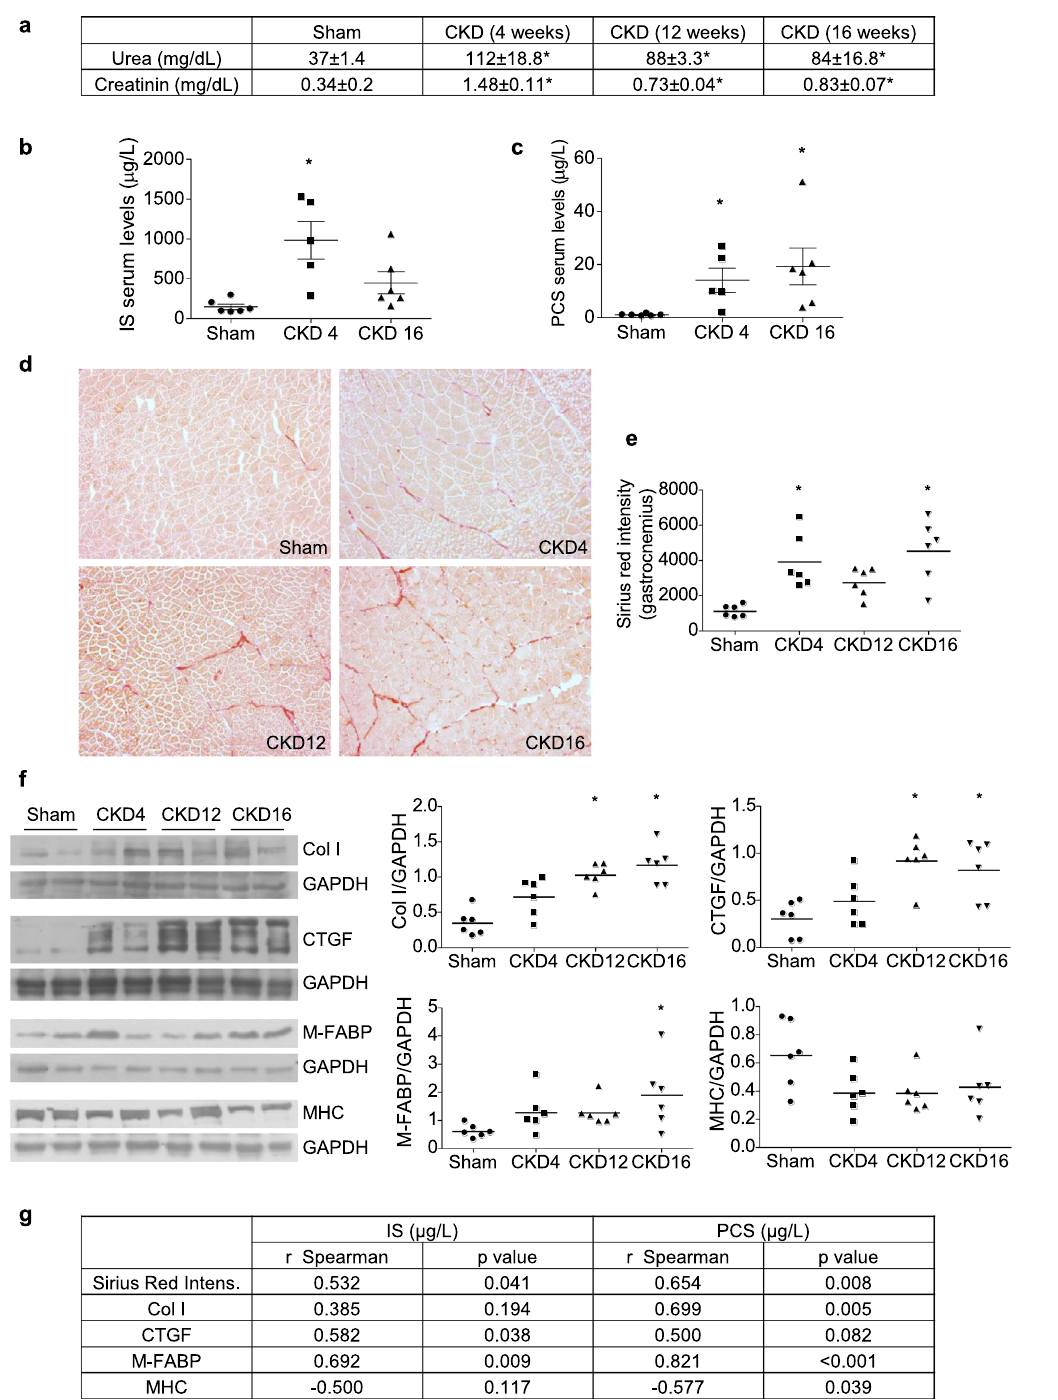
Figure 7. Uraemic rats show a higher rate of fibrosis and adiposis in gastrocnemius muscles. Seven/eight nephrectomised (CKD) or sham operated (Sham) rats were euthanised 4, 12, or 16 weeks after surgery, and gastrocnemii were isolated. ( a ) Urea and creatinine serum concentrations. Results are expressed as mean ± SEM from six animals per group. * p < 0.05 versus Sham. ( b ) Serum concentration of indoxyl sulphate (IS). * p < 0.05 versus Sham. ( c ) Serum concentration of p-cresyl sulphate (PCS). * p < 0.05 versus Sham. ( d ), ( e ) Sirius red staining of gastrocnemii is shown in the left panel. Graph represents the Sirius red intensity measured in six animals from each group by three different researchers. * p < 0.05 versus Sham. ( f ) Collagen I (Col I) and CTGF, Muscle FABP (M-FABP) and Myosin heavy chain (MHC) expression were analysed by western blotting. Typical blots are shown. Full-length blots are presented in Supplementary Figure S3. Graphs show the densitometric analysis of the bands from six animals from each group. * p < 0.05 versus Sham. ( g ) Spearman correlation coefficients, along with p-values, between serum concentrations of IS and PCS with fibrosis markers (Sirius red intensity, Col-I, CTGF), with an adiposis marker (M-FABP) and with a mature myotube marker